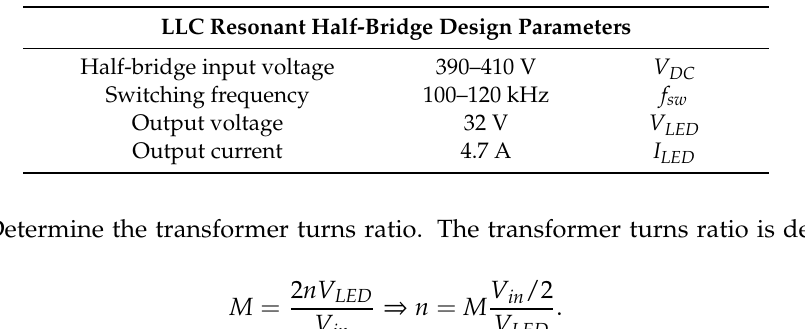
Table 3. Parameters of LLC resonant DC-DC